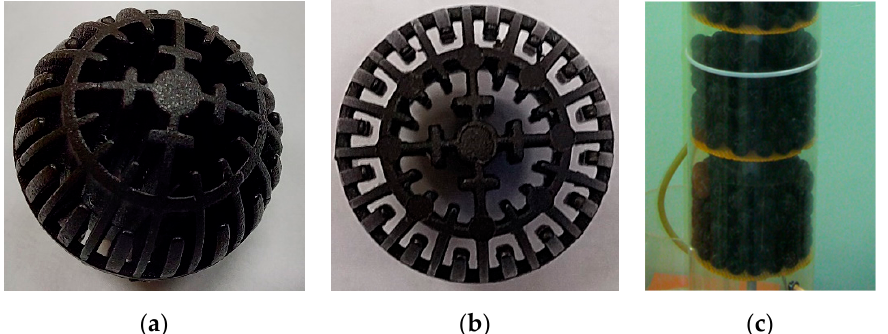
Figure 2. Plastic biological ball filters (i.e., bioballs): ( a ) plastic bioball; ( b ) top view of bioball; ( c ) bioballs in the biotrickling